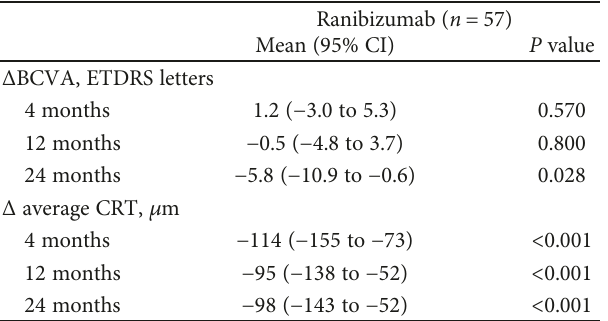
Table 4: Two-year results on Ranibizumab treatment for neovascular age-related macular degeneration in patients aged ≥ 90 years.